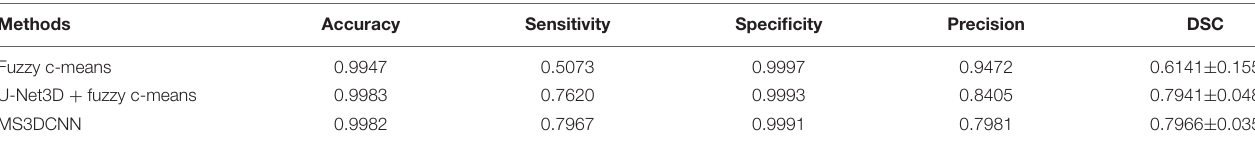
Frontiers in Neuroinformatics |